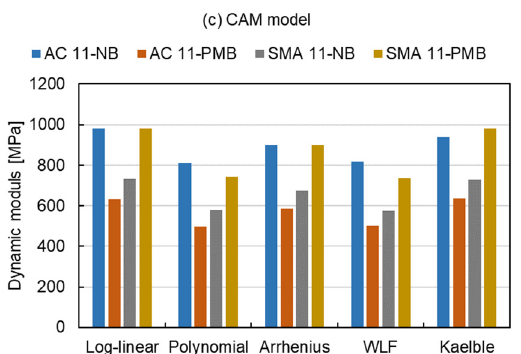
Figure 8. Modelling values of dynamic modulus at the reduced frequency of 10 − 2 Hz ( T r = 15 °C).